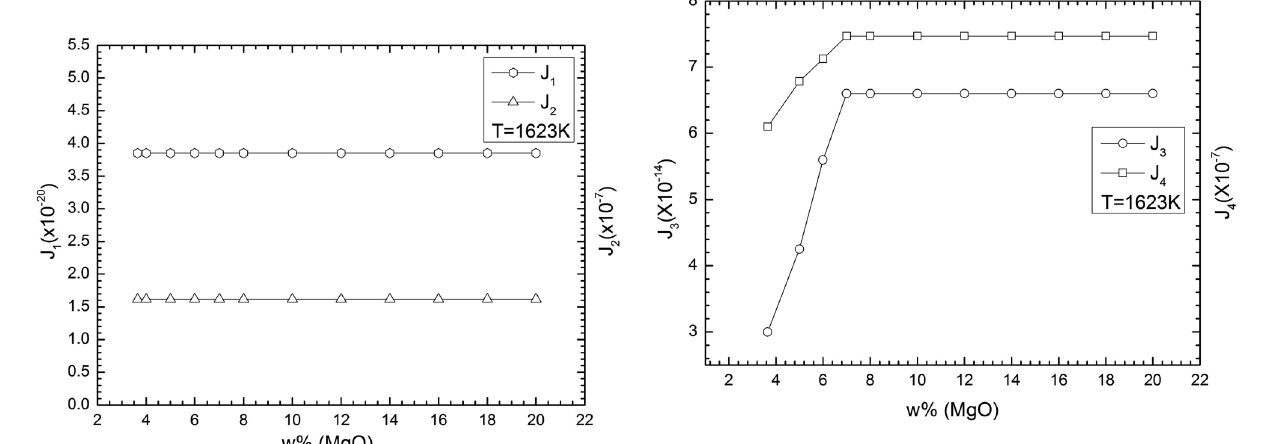
Fig. 6: The variation of activity product J 3 and J 4 with addition amount of